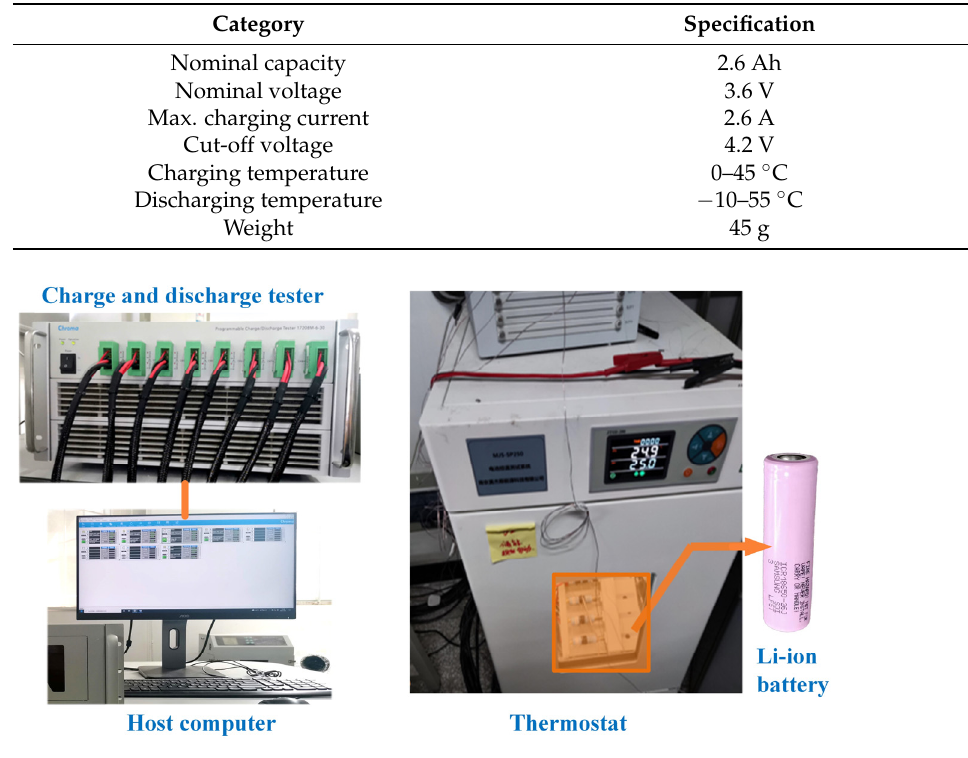
Figure 5. Ba tt ery experimental testing equipment.